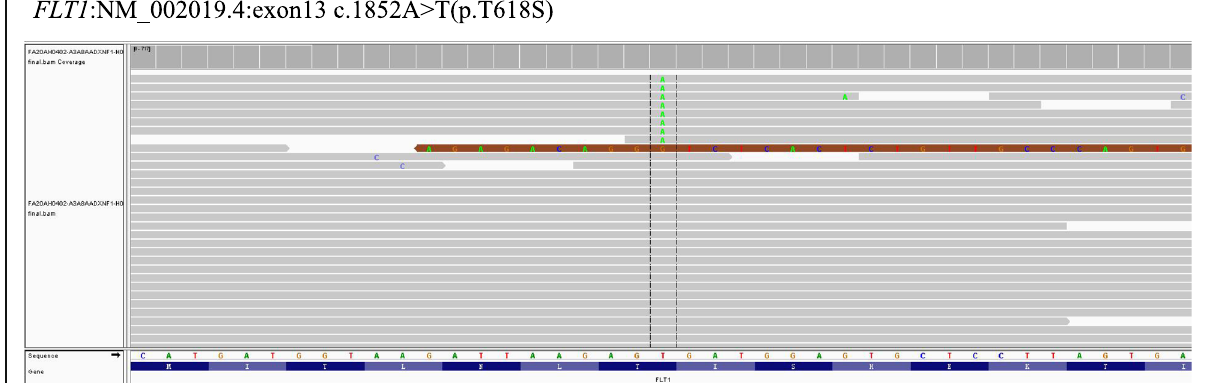
Fig. 7 Integrative Genomics Viewer (IGV) split-screen view of read alignments of the identified mutations of FLT1 :NM_002019.4: exon13 c.1852 A > T(p.T618S) in case 2